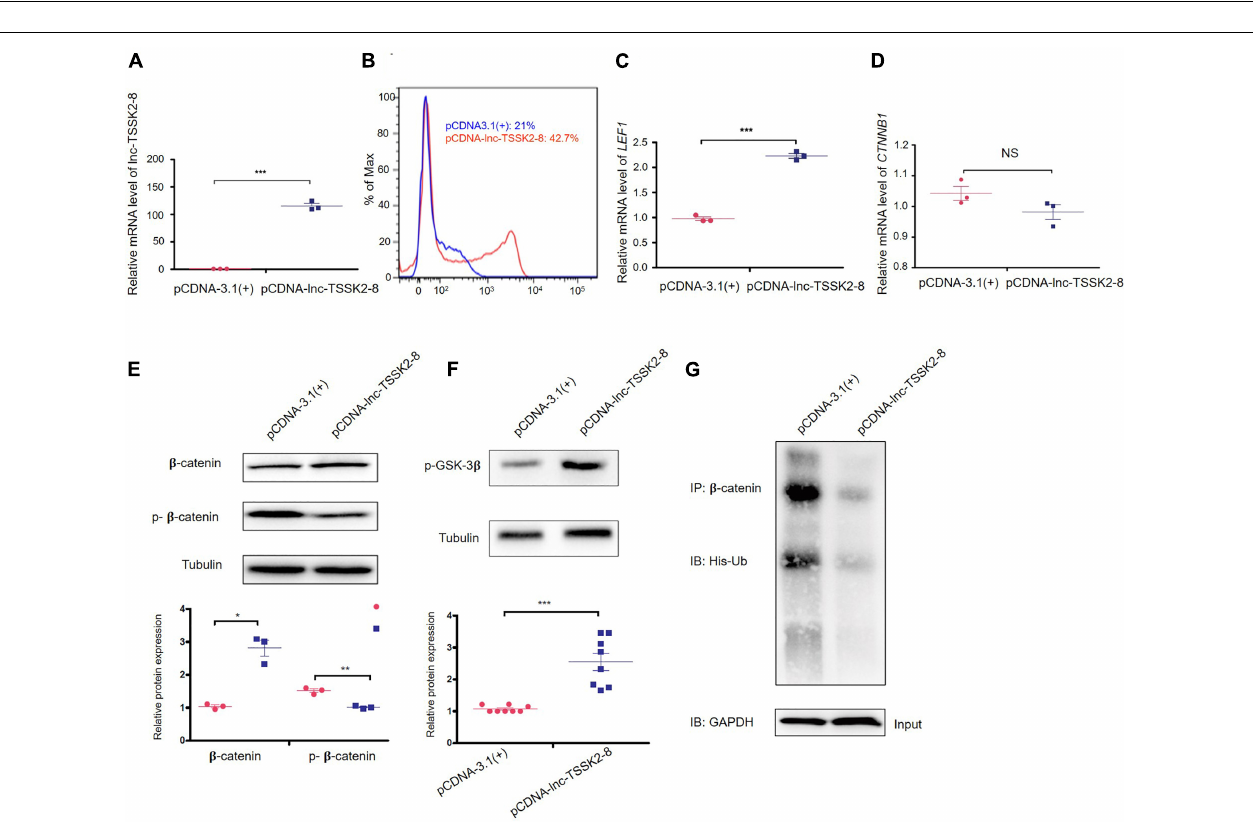
FIGURE 1 | Full-length characterization and subcellular expression analysis of lnc-TSSK2-8 . (A) Electrophoresis analysis of rapid amplification of cDNA ends (RACE) PCR and the obtained full-length cDNA sequence of lnc-TSSK2-8 . (B) Subcellular distribution of lnc-TSSK2-8 . Glyceraldehyde 3-phosphate dehydrogenase (GAPDH) and U6 were used for references of cytoplasmic expression and nuclear expression, respectively.